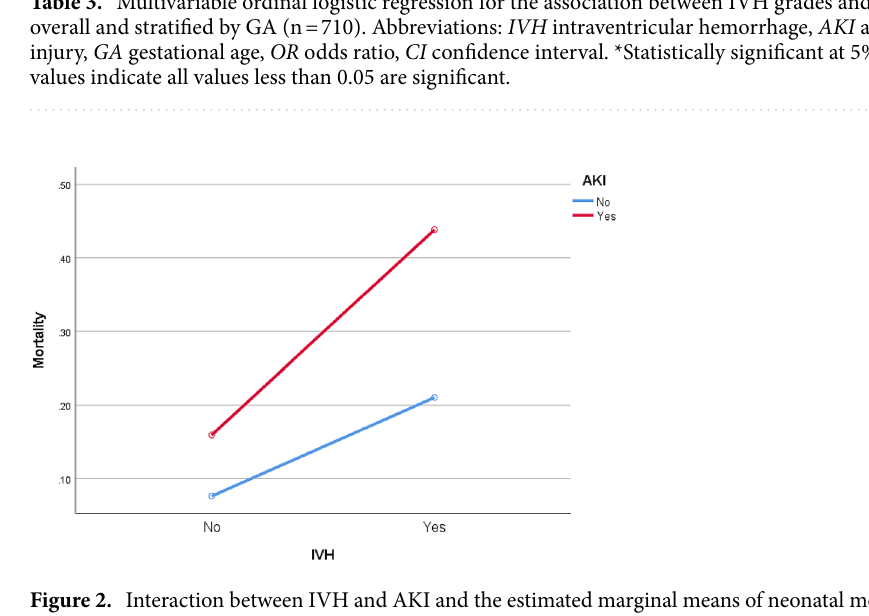
Figure 2. Interaction between IVH and AKI and the estimated marginal means of neonatal mortality (n = 710). Abbreviations: IVH intraventricular hemorrhage, AKI acute kidney